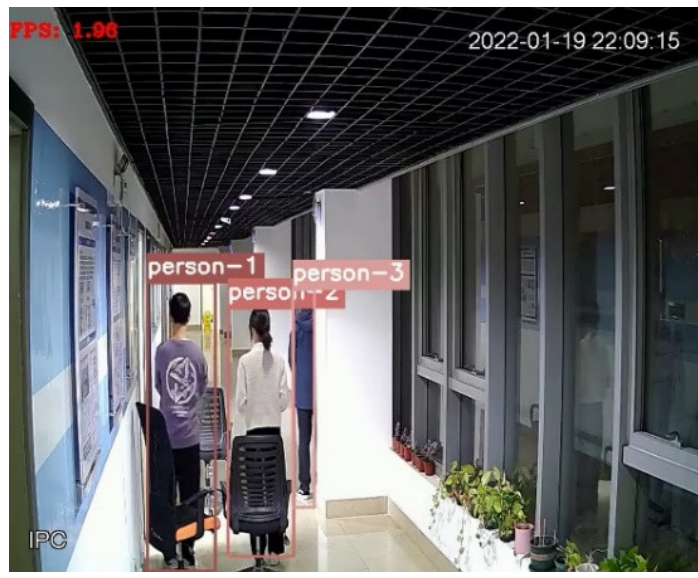
Figure 14. The effect of the DeepSort algorithm with obstacles.